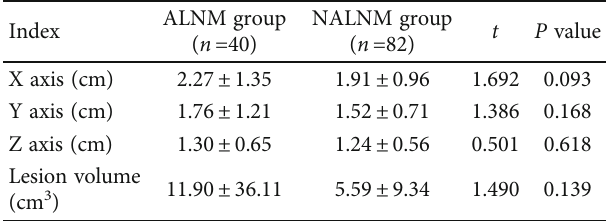
Table 2: Comparison of lesion size between the two